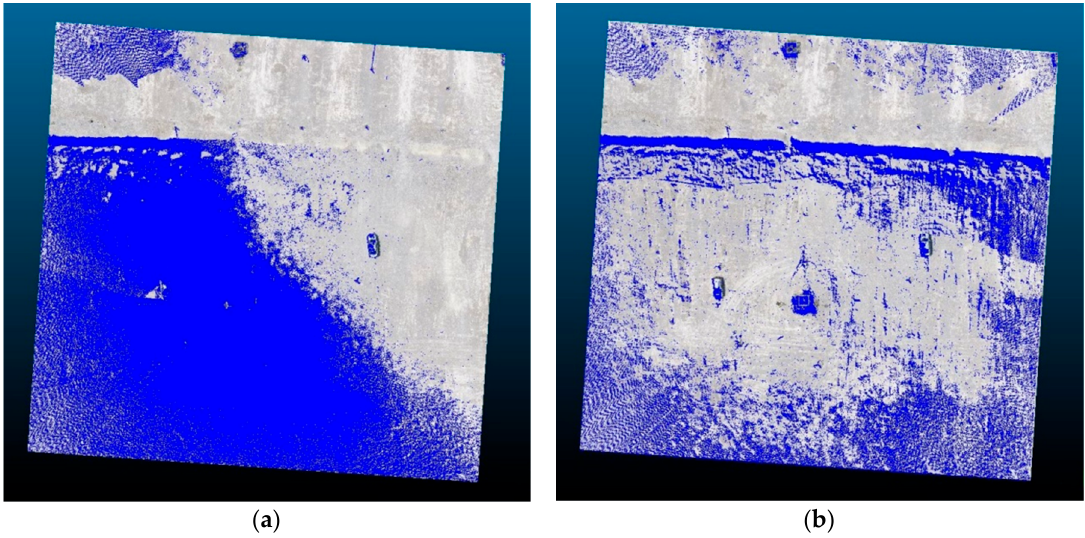
Figure 15. The TLS (blue color) and UAV40 (grayscale) point clouds: ( a ) Before registration; ( b ) after registration with the new target.